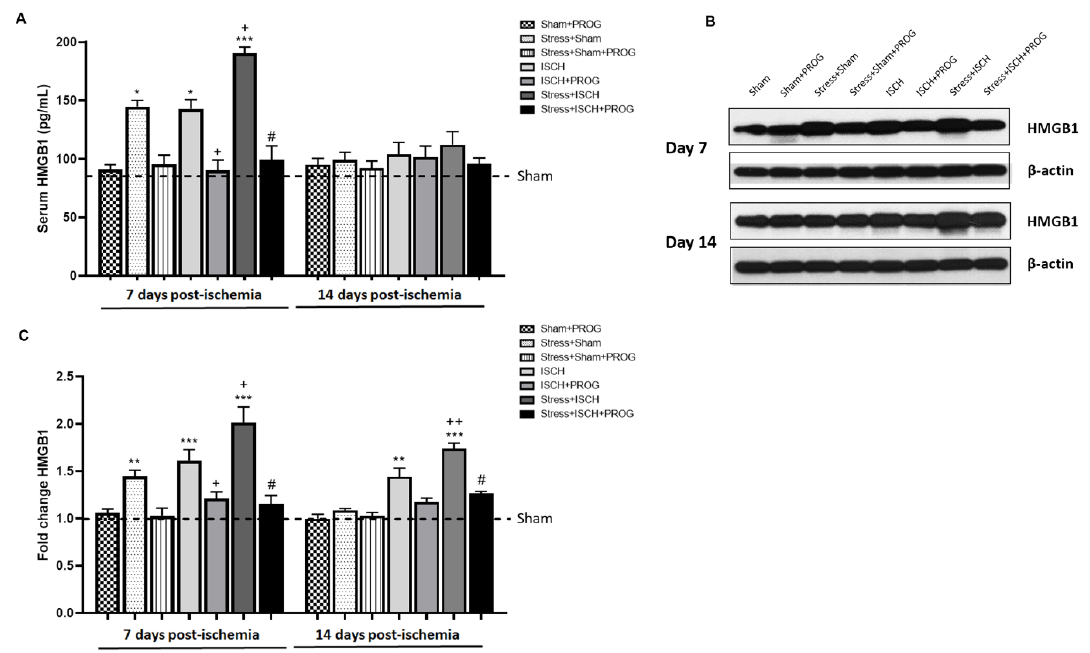
Figure 1. Effects of stress and progesterone on HMGB1 release induced by global ischemia. ( A ) Levels of HMGB1 in serum [ANOVA F(15, 80) = 11.26, p < 0.0001], ( B ) representative blots and ( C ) densitometry data for HMGB1 in the hippocampus [ANOVA F(15, 80) = 18.23, p < 0.0001], obtained from ischemic animals at 7 and 14 days after global ischemia, or from sham animals. Data are expressed as mean ± SEM. N = 6/group. * p < 0.01, ** p < 0.001, *** p < 0.001 vs. Sham; + p < 0.05, ++ p < 0.01, +++ p < 0.001 vs. ISCH; and # p < 0.001 vs. STRESS+ISCH.